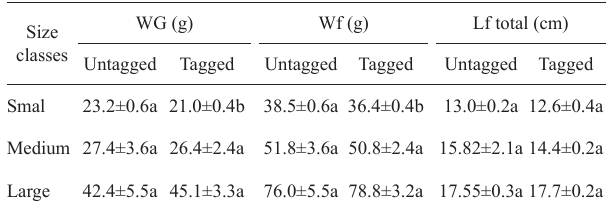
Tab. 2. Weight gain and final weight and lengthof the Lo­ phiosilurus alexandri in the different size classes after 90 days. Weight gain (WG), final weight (Wf) and final length (Lf). Means for tagged and untagged fish of the same size class followed different letters differ significantly ( p < 0.05)